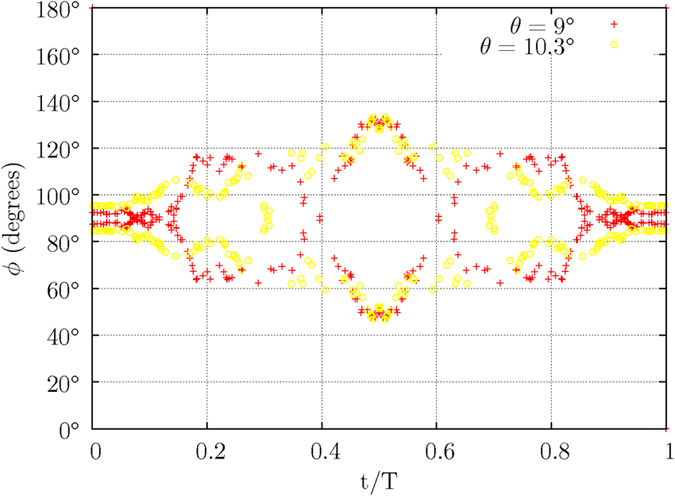
The azimuthal angles of two magnetic moments at their θpeak.